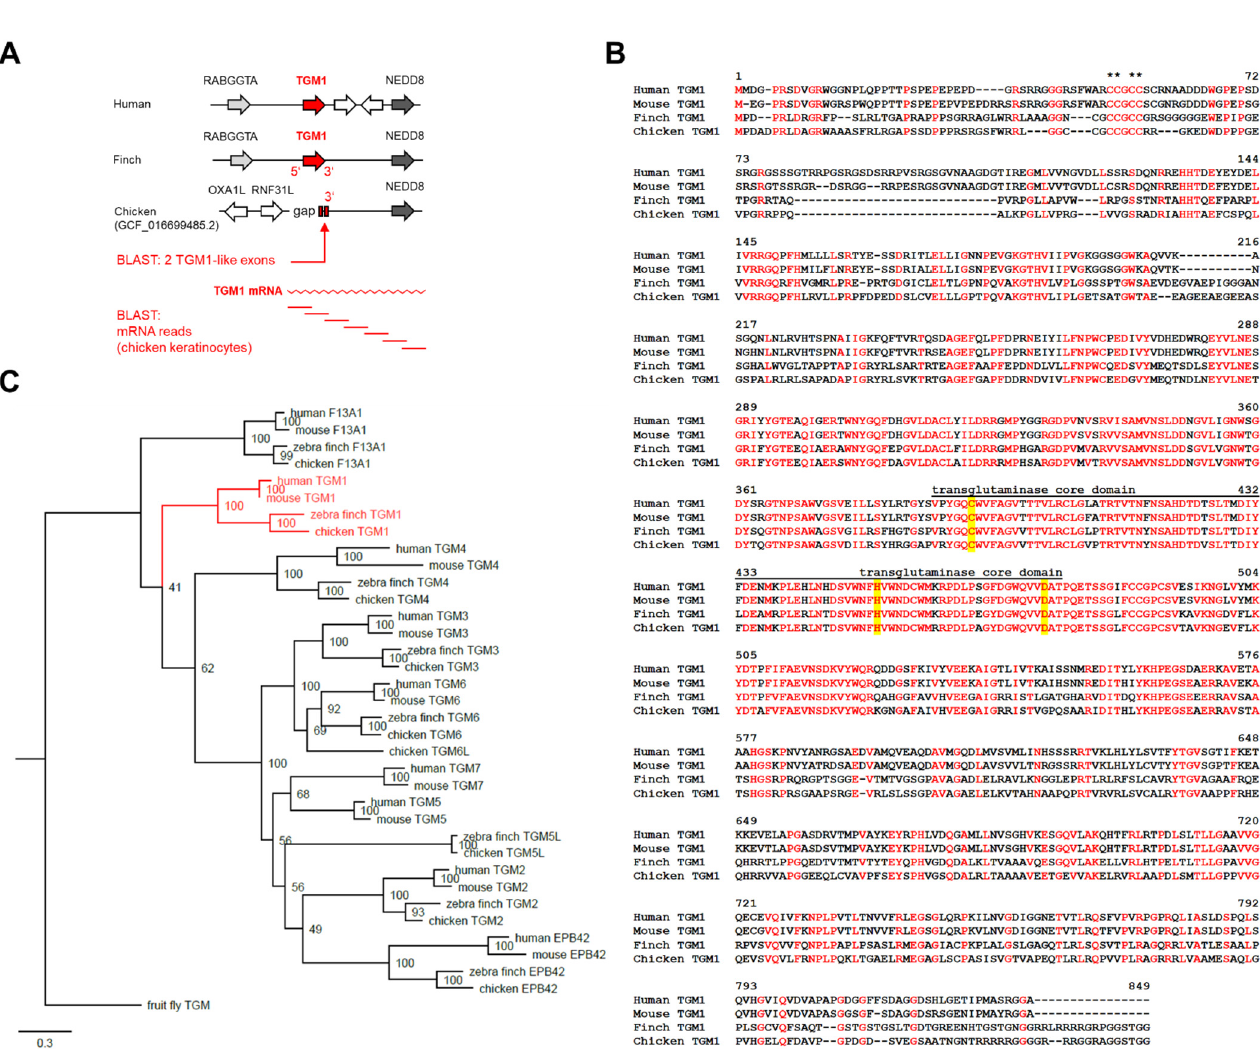
Figure 1. Identification and sequence of chicken TGM1 . ( A ) Gene locus of TGM1 in human, mouse, zebra finch and chicken. Synteny is indicated by the conserved genes TINF2 and NEDD8 (grey). Two TGM1 -like exons were identified at the position indicated by the arrow. Genes are indicated by arrows pointing in the direction of transcription. BLAST search for RNA-sequencing reads covering the 5’ regions of chicken TGM1 is schematically shown at the bottom of the panel. ( B ) Alignment of amino acid sequences of TGM1 proteins from human, mouse, zebra finch and chicken. Identical residues in all sequences are shown with red fonts. Asterisks indicate the cysteine residues at the palmitoylation site. The transglutaminase core domain [55] is marked by a line above the sequences. Residues of the catalytic triad are highlighted by yellow shading. ( C ) Phylogenetic analysis of TGMs from human, mouse, zebra finch and chicken.